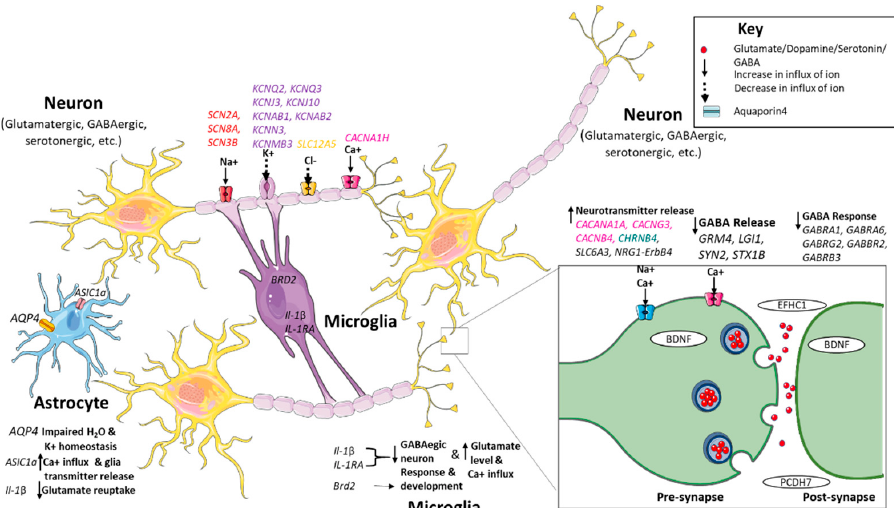
Figure 2. Epilepsy genes: Illustration of several possible patho-genetic mechanisms for common epilepsies. This figure represents the neural network of different cells involved in neurotransmission in brain tissues of epilepsy cases. A broad range of epilepsy mechanisms are implicated due to the identification of genes in the cell body, axon, pre-synapse, post-synapse and in neuroglia. Variation in these genes cause gain or loss of function, culminating in channelopathy disturbance, transporter